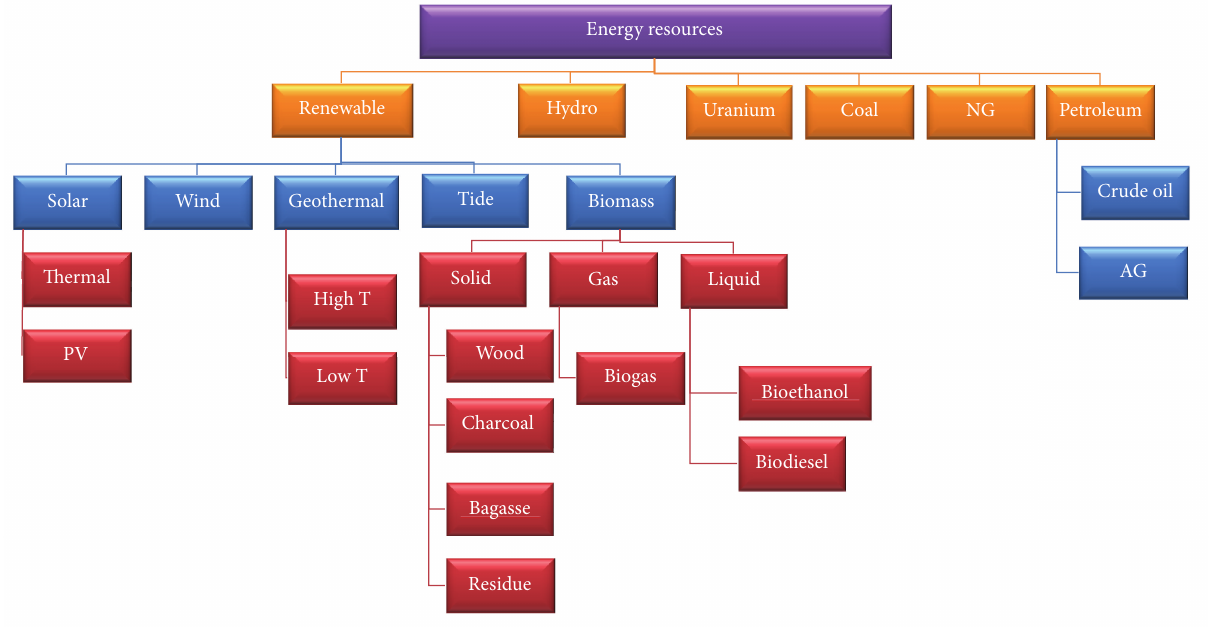
Figure 2: Primary energy